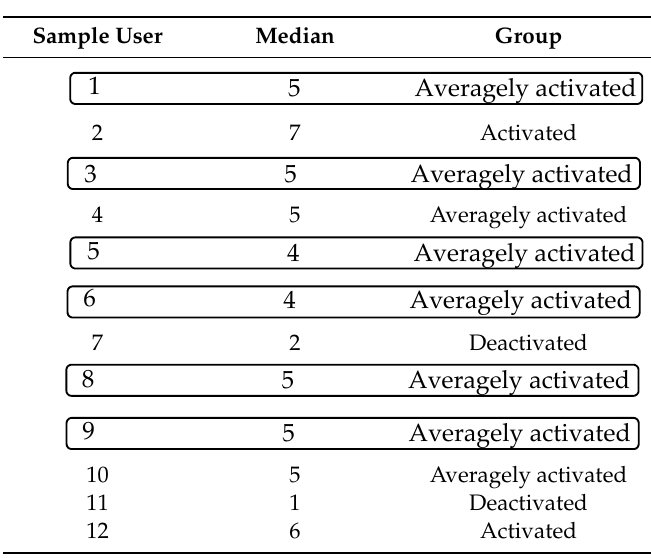
Table 6. Median computed on UES questionnaire scores and respective groups of engagement classification. Elements of the table highlighted by a box correspond to the participants for whom the UES method and the FER method gave the same response.